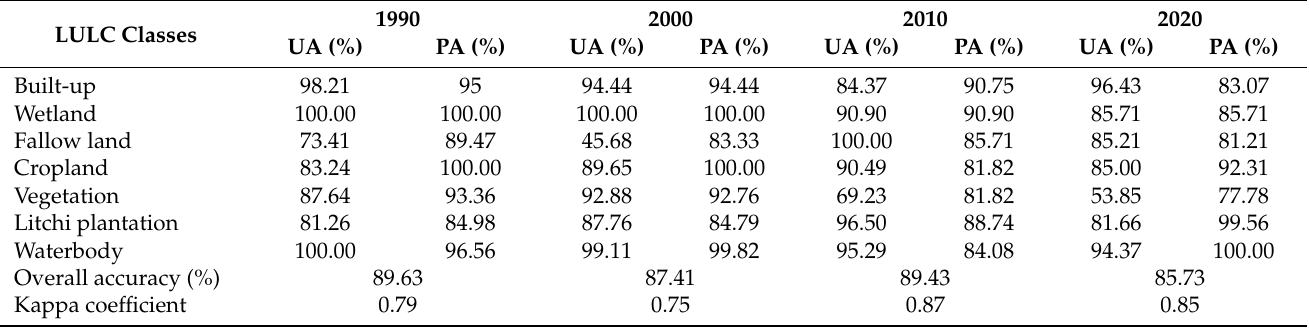
Table 5. Accuracy assessment of LULC maps of different